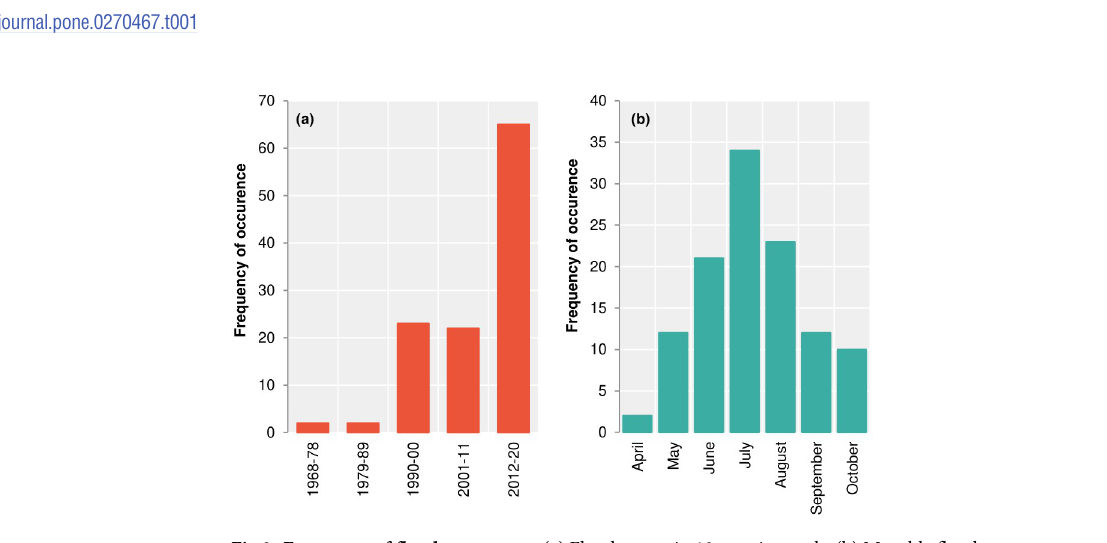
Fig 3. Frequency of flood occurrence. (a) Flood events in 10-year intervals, (b) Monthly flood events.